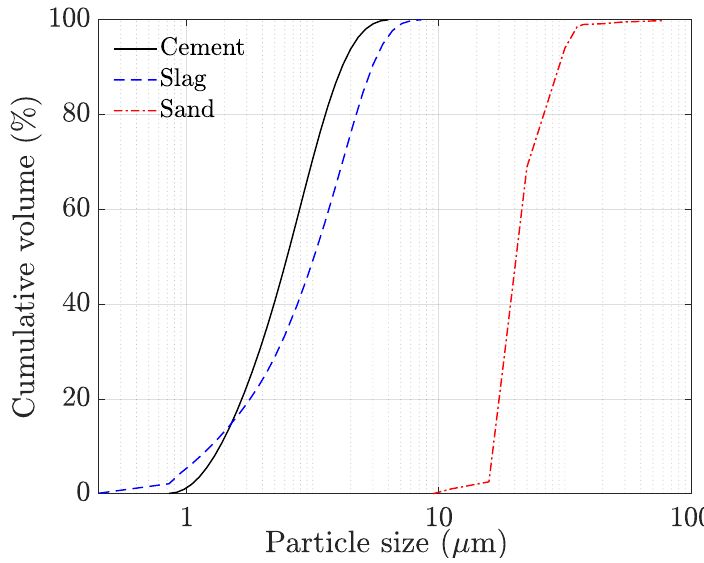
Figure 1. Particle size distribution of the binders and the aggregate. Table 2. Properties of the polypropylene fibers used in the study.